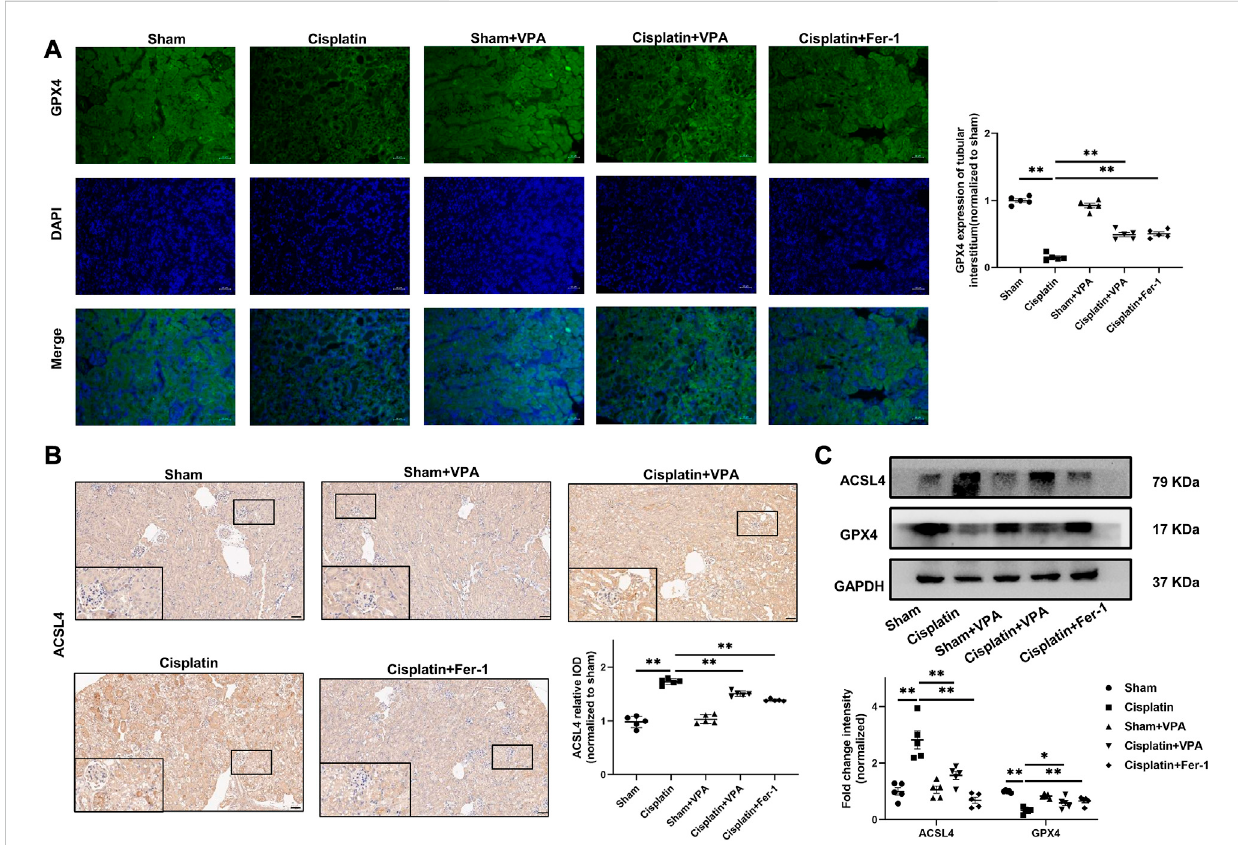
FIGURE 3 VPA treatment attenuates expression of ferroptosis-related proteins in cisplatin-induced AKI mice. Representative images of immuno fl uorescence of GPX4 in the tubulointerstitium of sham, cisplatin and VPA or Fer-1 treatment groups. Quanti fi cation of examining positive staining area of GPX4 in the tubulointerstitium normalized to sham group (A) . Immunohistochemical staining and semi-quantitative analysis for expression of ACSL4 (B) in different groups as indicated. Representative images of Western blot from different groups as indicated, including ACSL4 and GPX4, respectively (C) .